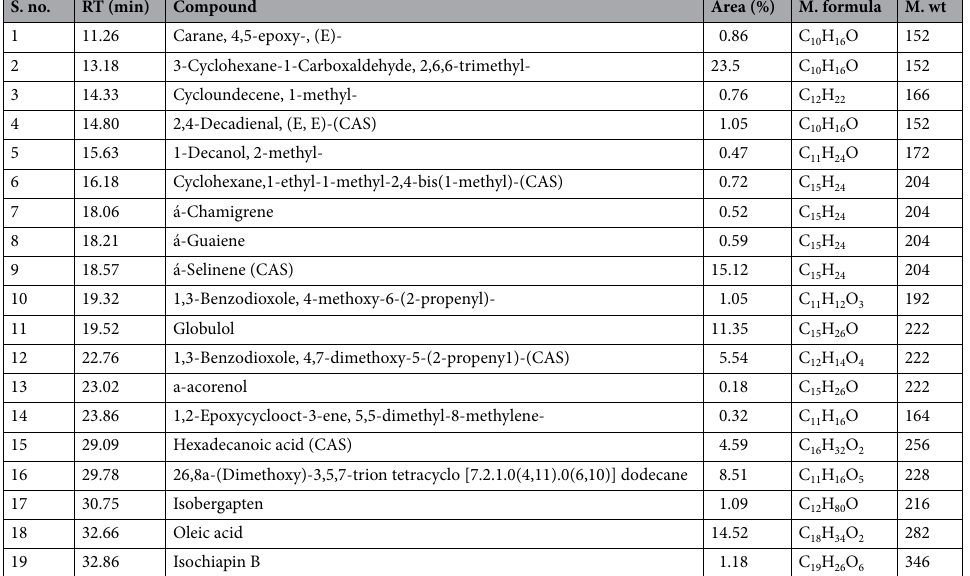
Table 4. GC-mass spectra of Acacia nilotica showing different active compounds. RT: Retention time per minute; active compounds detected by GC mass; area (%): percentage of compound; M. formula: molecular formula; M. wt: molecular weight of the